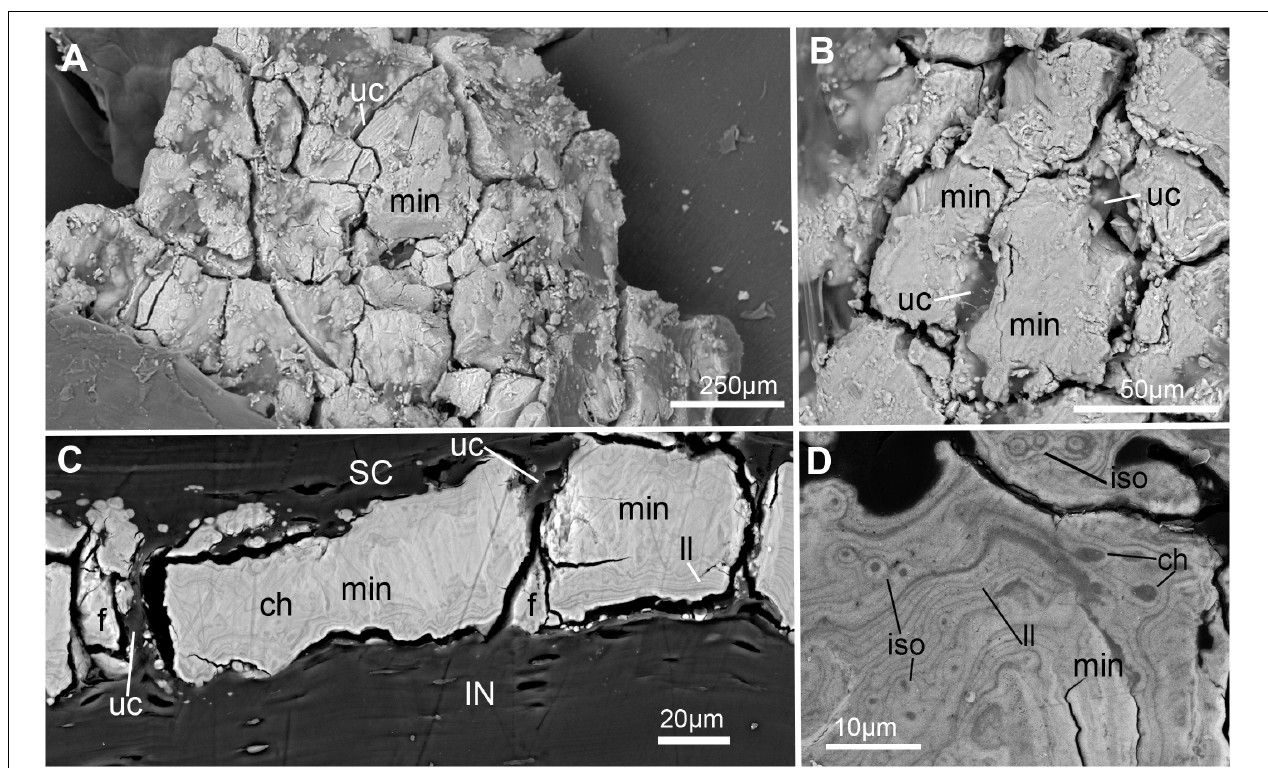
FIGURE 7 | SEM images of mineralization from the synarcual (anterior fused vertebrae) of an adult Callorhinchus milii (Holocephali; Callorhinchidae). (A) Overview of tesselated mineralization from a planar perspective; (B) close up of mineralization from a planar perspective; (C) mineralization from a transverse perspective; (D) close up of mineralization surface in transverse perspective; Note brightness and contrast of (C,D) have been altered to more clearly visualize morphology. Abbreviations: As in previous Figures, also f, fragments ll, Liesegang